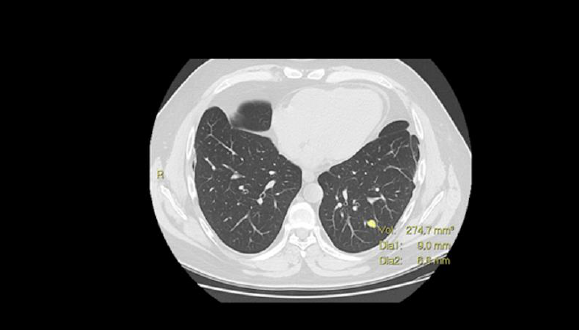
Figure 2. CT scan with nodule volume evaluation (mm 3 ) and maximum